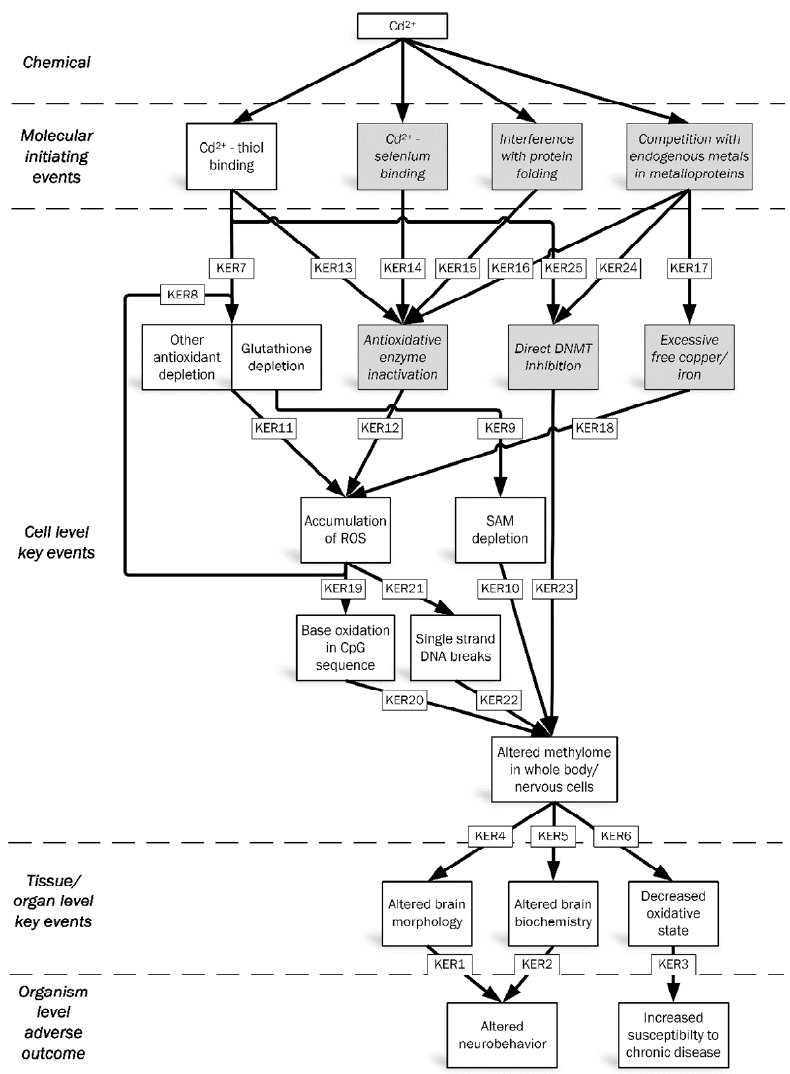
Figure 7. Hypothesized adverse outcome pathway (AOP) framework for embryonic subtoxic cadmium exposure leading to long term altered neurobehavior and antioxidative physiology. White and grey boxes, high and low probability key events, respectively. Numbering of KERs follows the order of description in the text.